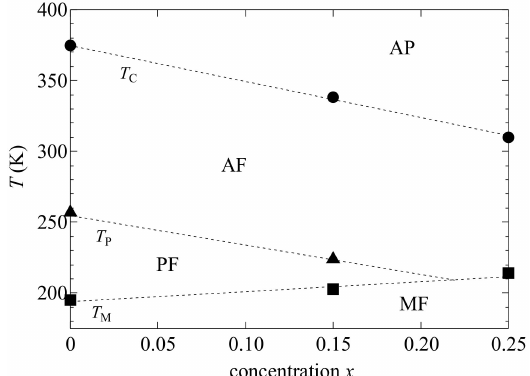
Figure 2. Phase diagram for Ni 2 Mn 1 − x Cr x Ga (0 ≤ x ≤ 0.25): martensitic ferromagnetic (MF) phase, premartensitic ferromagnetic (PF) phase, austenitic ferromagnetic (AF) phase, and austenitic paramagnetic (AP) phase. Data from Ref. [27]. T. Sakon, et al. Metals 2017 , 7 , 410. MDPI, doi:10.3390 / met7100410.